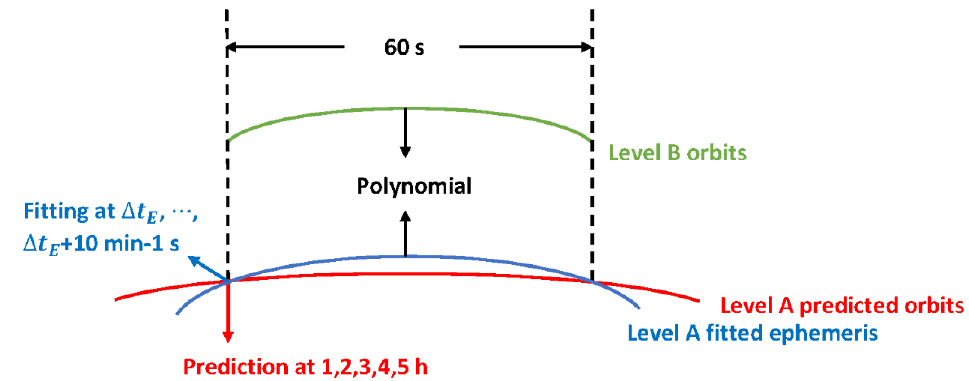
Figure 14. Test strategy for the low-order polynomial corrections merging the Level A and Level B orbits.